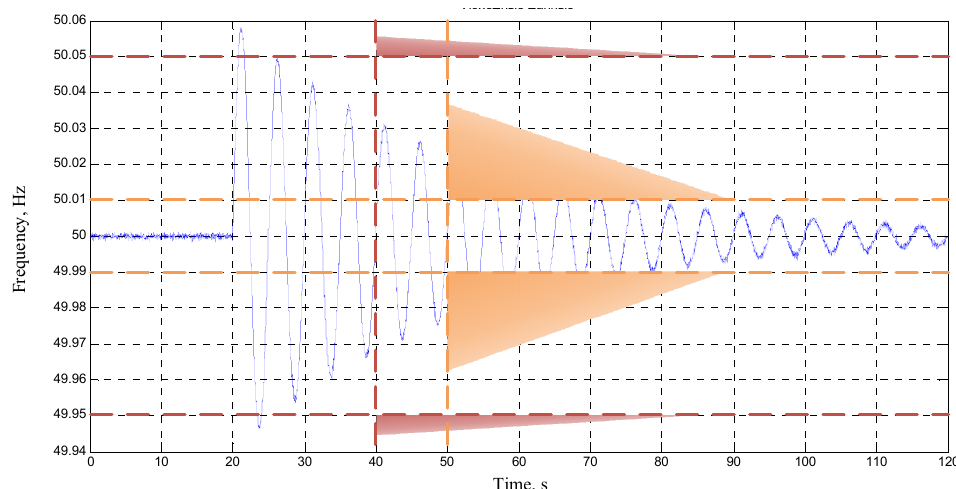
Figure 6. Visual representation of LFO threat criteria for a case of frequency.